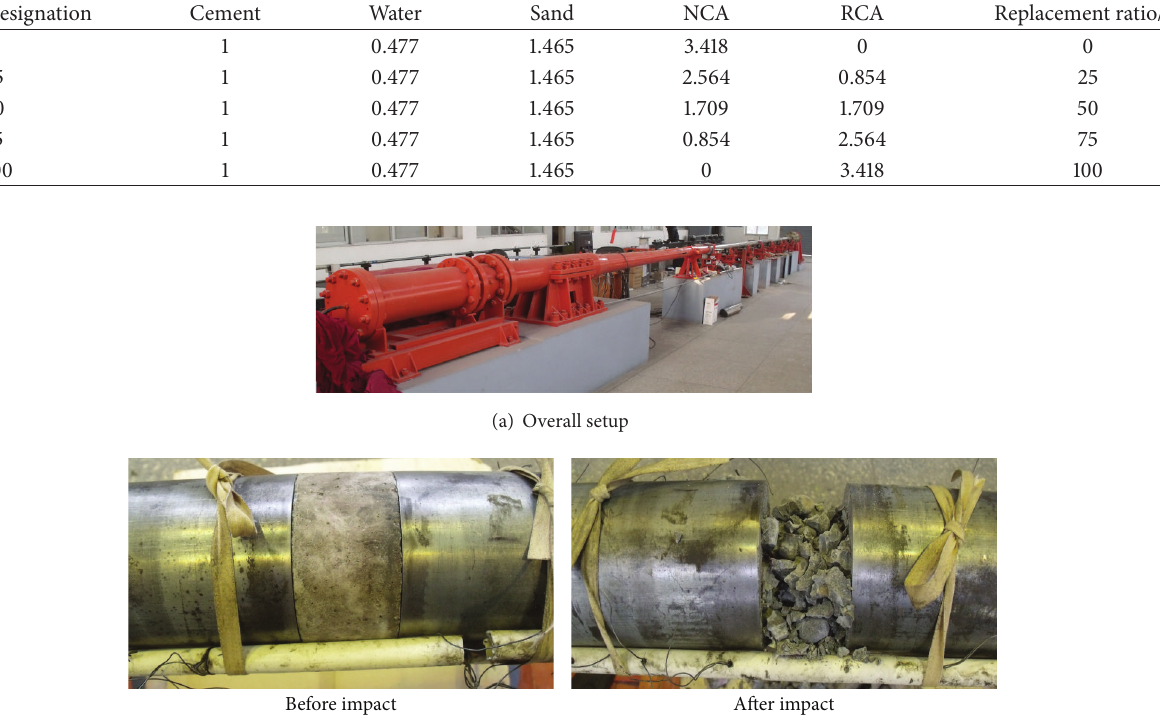
Figure 1: The 100-mm-diameter SHPB